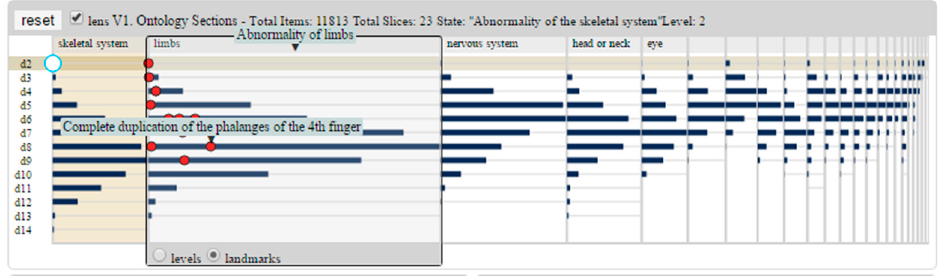
Figure 24. The selection of the “Abnormality of the Skeletal System” section. We now move to the Sections Levels Panel subview, directly below the Ontology Sections Panel subview, which magnifies the levels of the selected ontology section and the ontology entities contained within it. We begin our inspection of the various levels of this ontology section, seeing the number of ontology entities in each level. This provides us the potential to build route knowledge of the ontology entities we have encountered and used as landmarks. Figure 25 shows the initial state of the Sections Level Panel sub- view. We see that there are 14 levels within the section and that there are 9 ontology enti- ties in the second level of the section. We also see a more detailed representation of the contents of each level, where levels like depth 11 (d11) carry a significant number of on- tology entities, while others carry less.